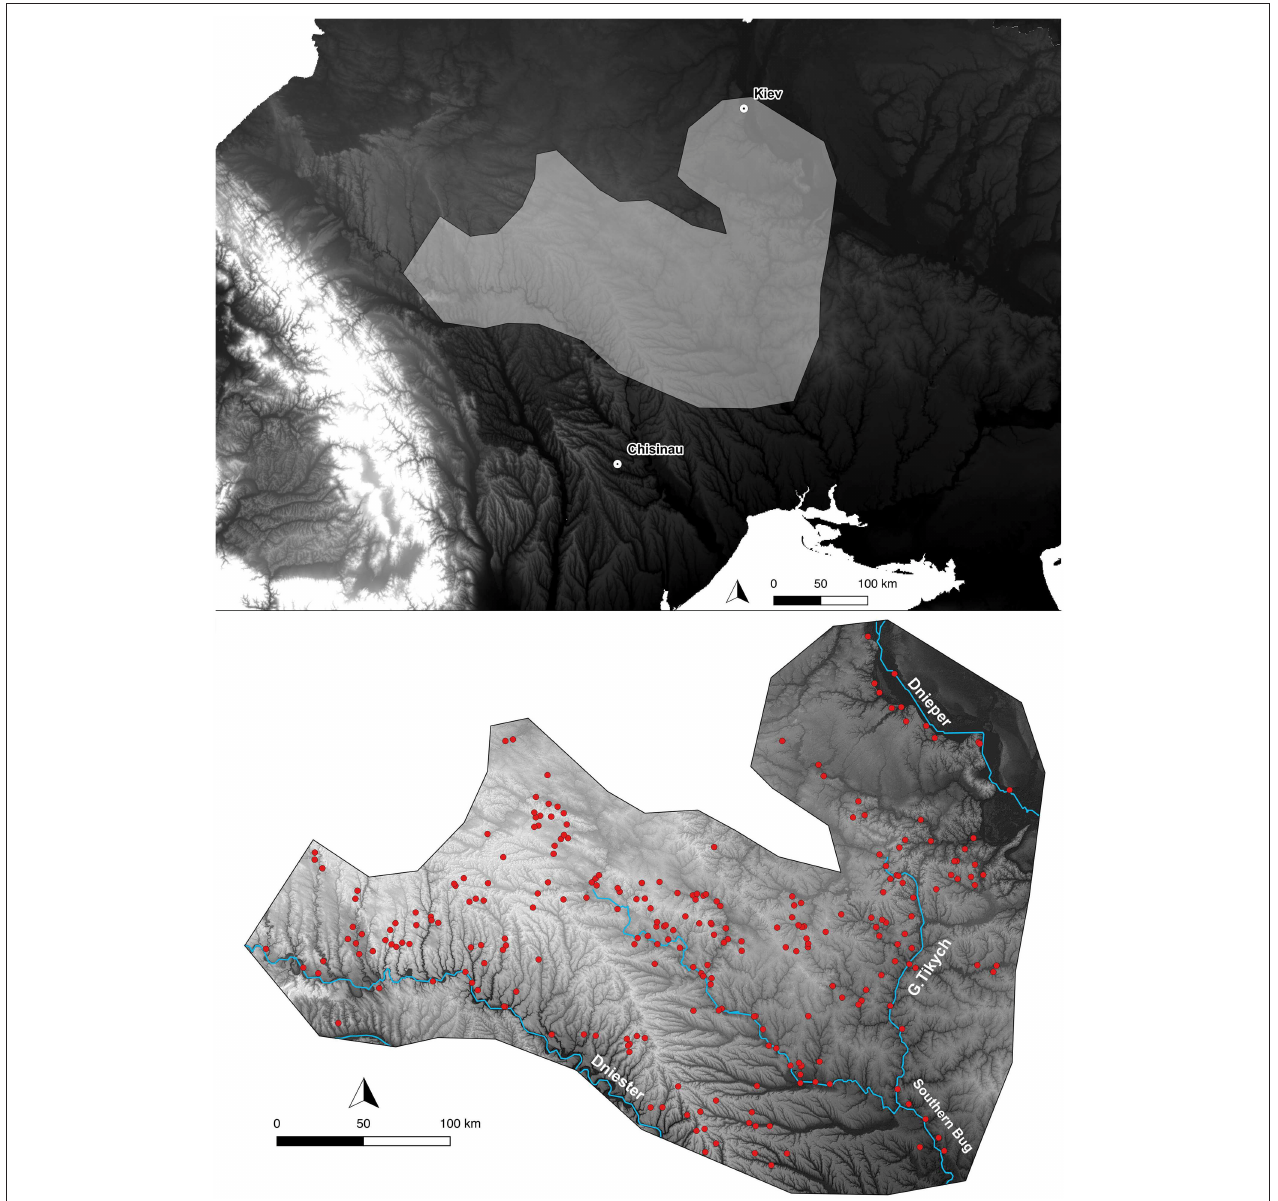
FIGURE 4 | Location of the study area (Top) and overall distribution of all sites (red) considered in the study (Bottom) . Main rivers are plotted for reference in the